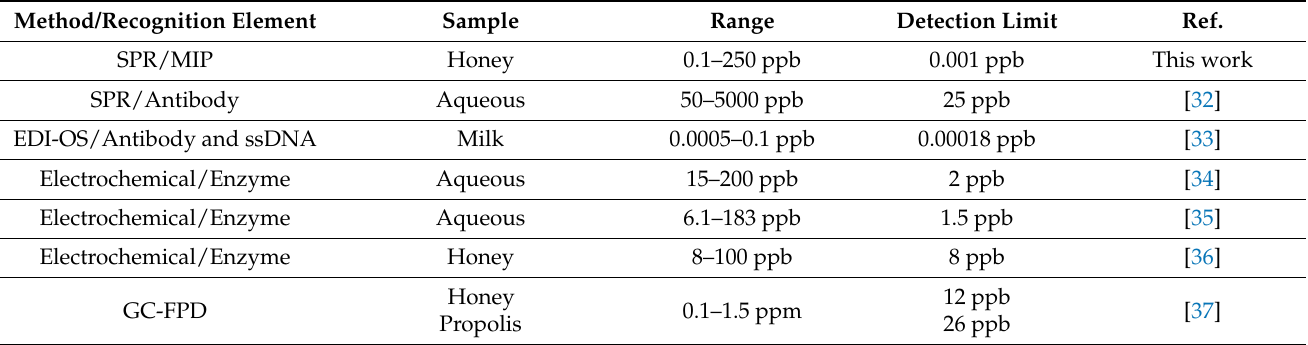
Table 5. Studies that compare the detection of coumaphos using different methods or